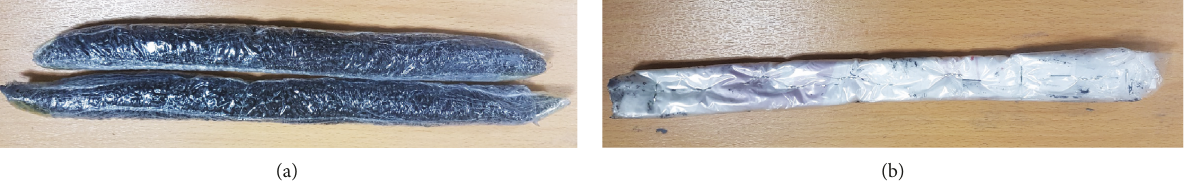
Figure 5: Additives to the PV panel between its backside and the installed fi ns: (a) HDPE grain wraps and (b) folded plastic bags.